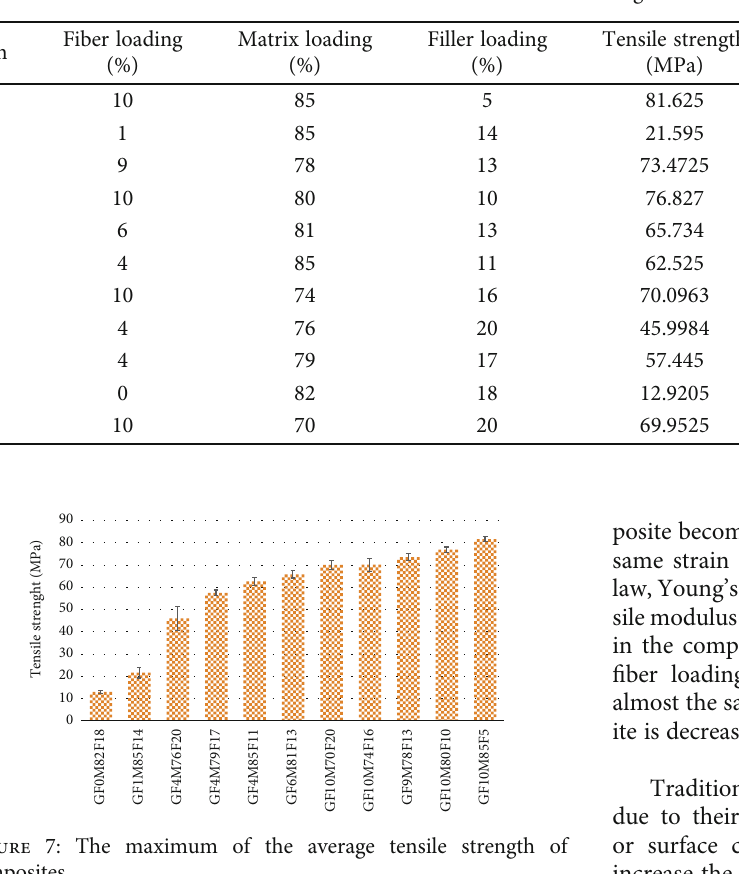
Table 4: Test results of the average mechanical property.